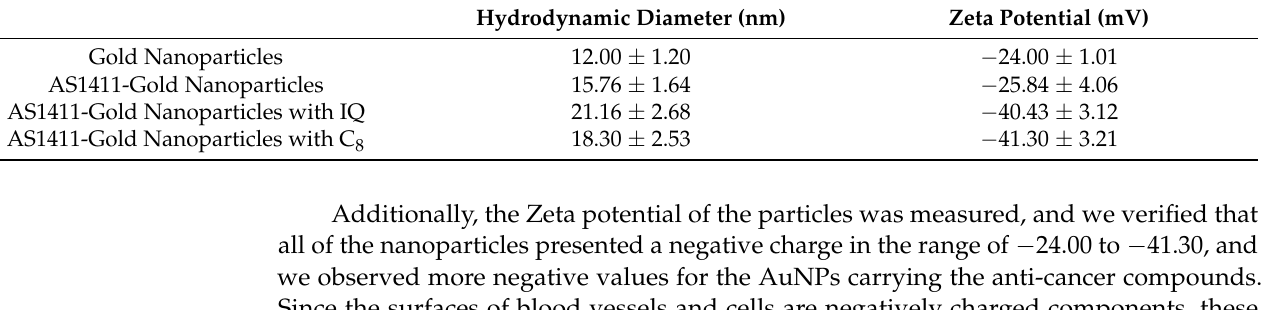
Table 1. Hydrodynamic diameter and Zeta potential of the Table 1 . Hydrodynamic diameter and Zeta potential of the nanoparticles.